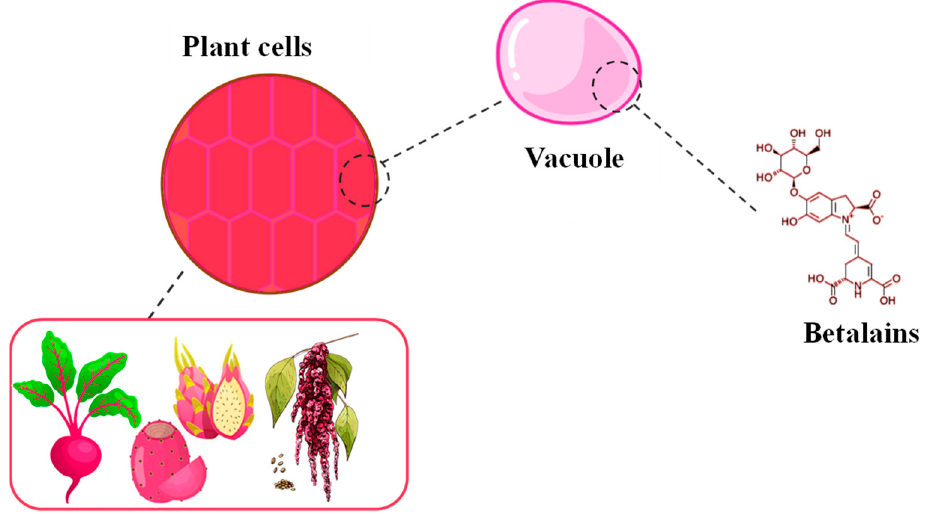
Figure 2. Schematic representation of the main sources and vacuole structure containing